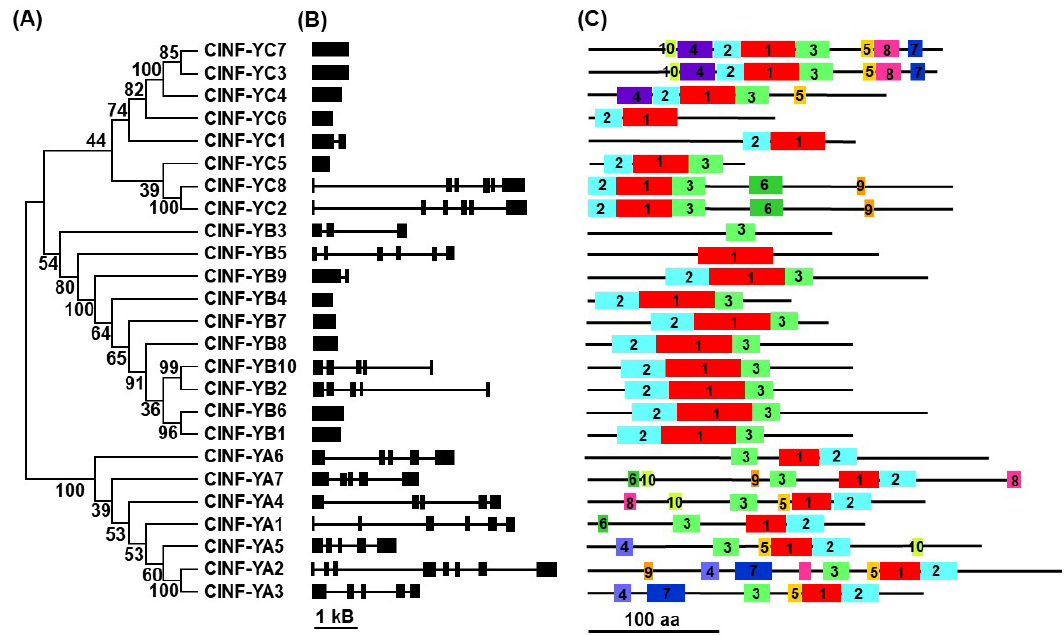
Figure 2. Phylogenetic relationships, gene structure, and conserved motifs in ClNF-Y proteins. ( A ) Phylogenetic relationships between the 25 ClNF-Y proteins. ( B ) Structures of the watermelon ClNF-Y genes. Exons and introns are indicated by filled boxes and thin lines, respectively. ( C ) Organization of conserved motifs in ClNF-Y proteins. Different colored boxes with numbers represent different motifs (see Figure S2 for details).